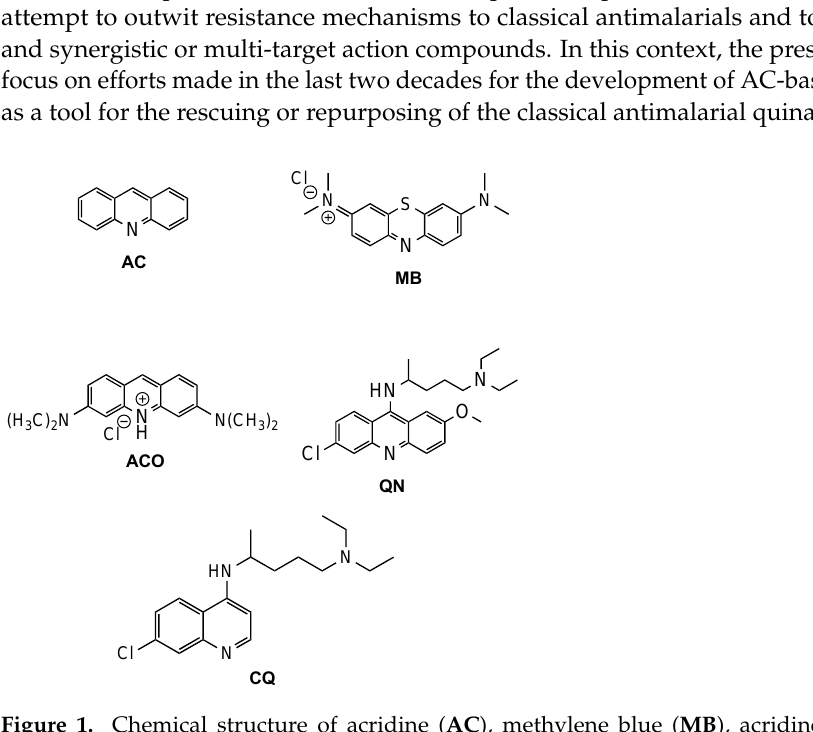
Figure 1. Chemical structure of acridine ( AC ), methylene blue ( MB ), acridine orange ( ACO ), quinacrine ( QN ) and chloroquine ( CQ ).